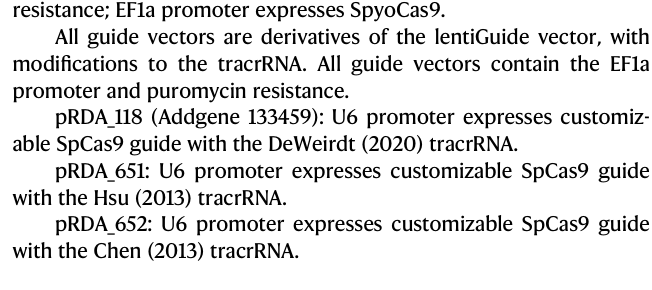
Fig. 2 | Rule Set 3 (Sequence+Target) validation. a Schematic depicting essen- tial/non-essential tiling library construction and screening approach. b Spearman correlations between observed and predicted activity for all essential genes ( n =201)in each of theessential/non-essentialscreens across previous modelsand RuleSet3models.RuleSet3modelsusingthesametracrRNAfeatureasthescreen are highlighted in pink and signi fi cantly outperformed other models (one-sided t - test p value<0.002).Boxesshow25thand75thpercentilesasminimaand maxima and the center represents the median; whiskersshow the 5thand 95th percentiles. c PercentofallsgRNAstargetingessentialandnon-essentialgenesbrokendownby Rule Set 3 (Sequence + Target) bins for the Hsu and Chen tracrRNAs. d Spearman correlations between predicted scores and the growth phenotype for sgRNAs ( n =1964) targeting essential genes in a tiling CRISPRi dataset across all sequence